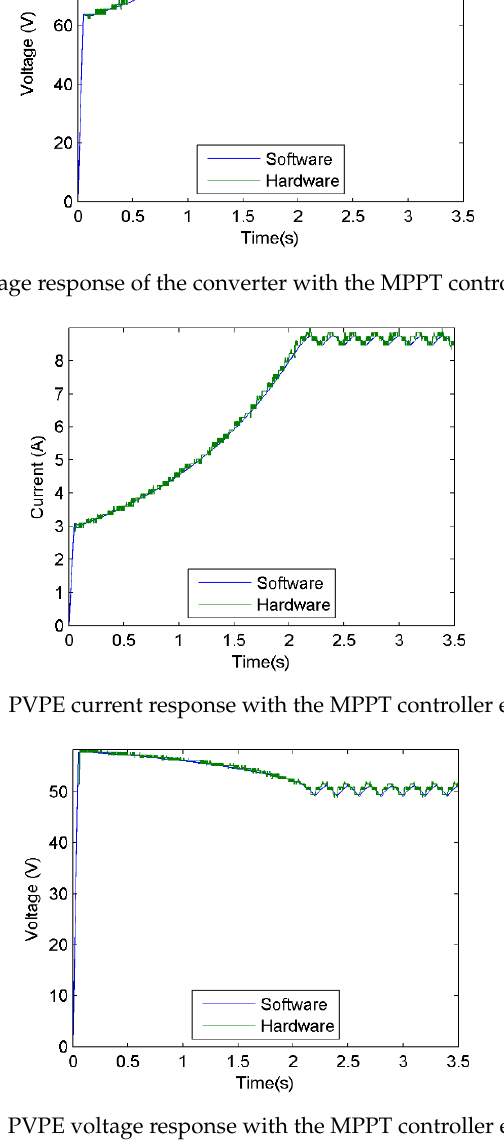
Figure 28. PVPE voltage response with the MPPT controller emulator.